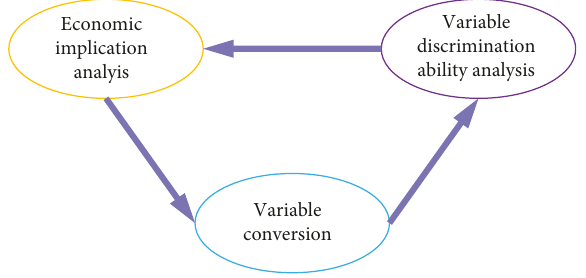
Figure 3: Univariate